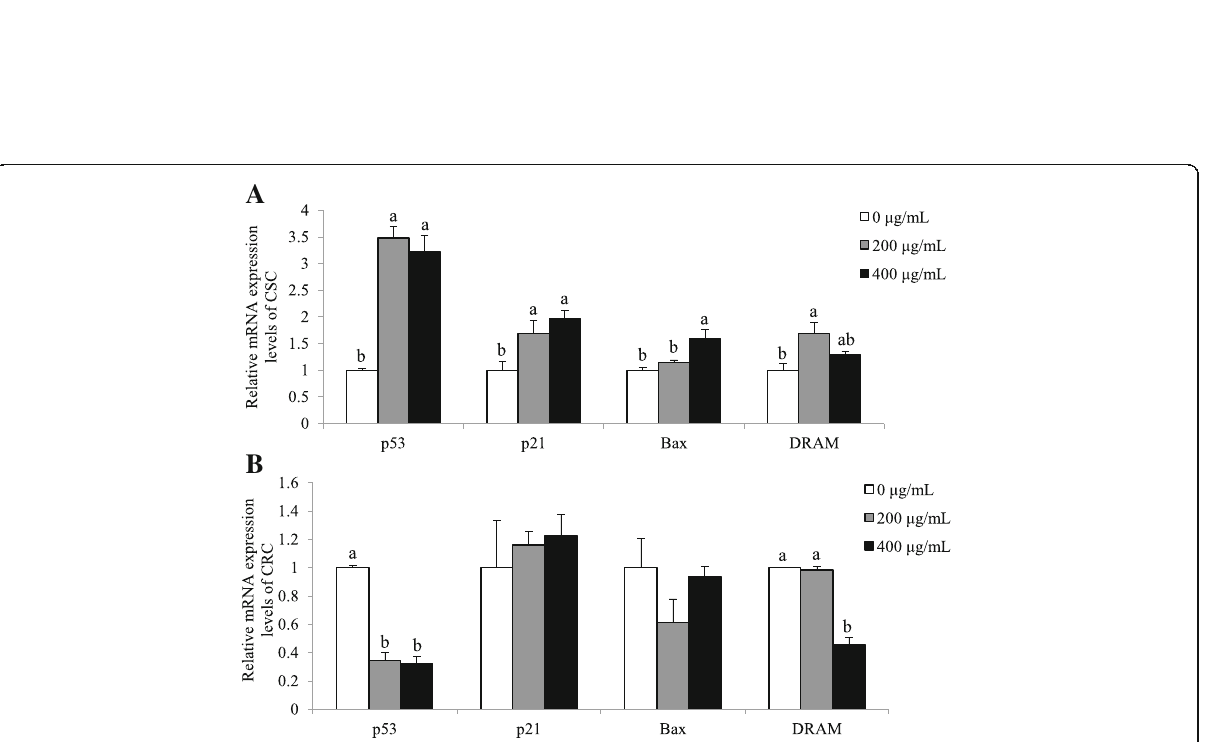
Fig. 4 Effects of SbE on mRNA expression levels of p53 , p21 , Bax , and DRAM in CSC and CRC. After cells were exposed 200 ~ 400 μ g/mL of SbE for 24 h, mRNA expression levels of ( a ). p53 , p21 , Bax , and DRAM in CSC and ( b ) p53 , p21 , Bax , and DRAM in CRC were quantified by qPCR. All mRNA expression levels were normalized against TBP . Each value is the mean ± SD. p < 0.05 was taken to define statistical significance. One-way ANOVA followed by Duncan post hoc